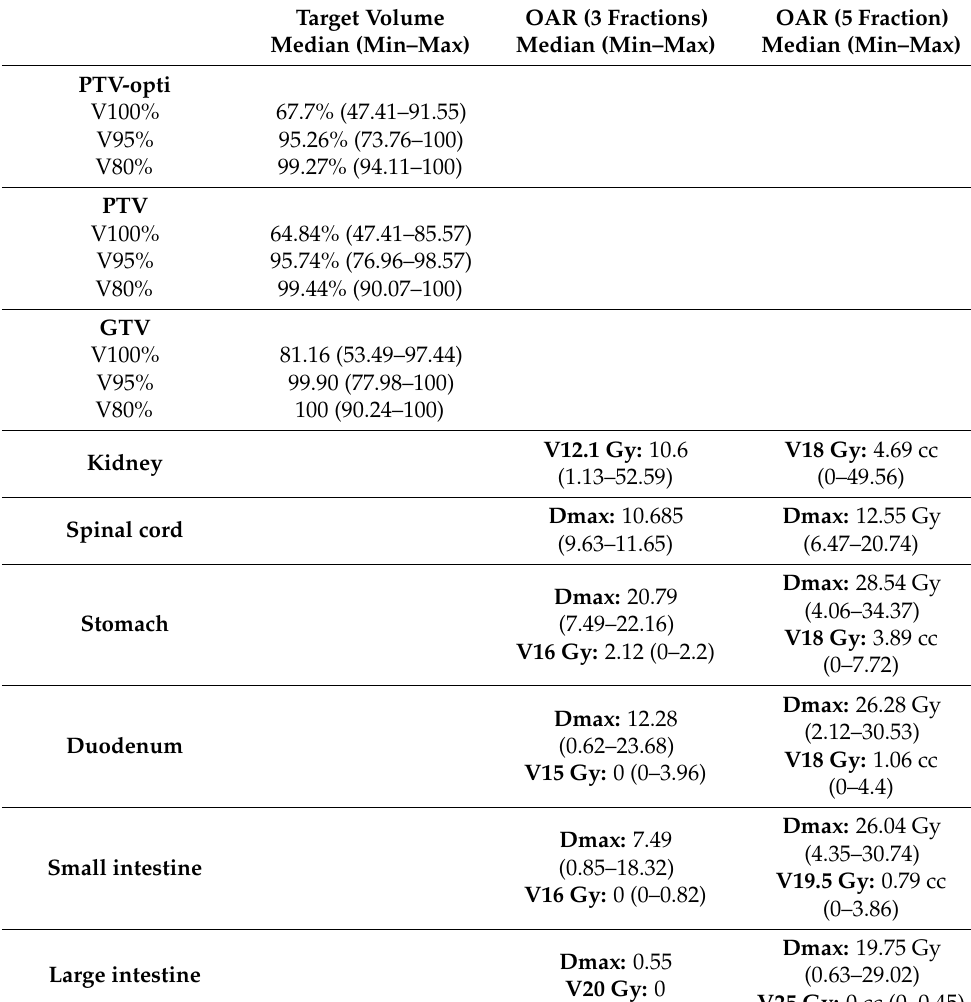
Table 3. Target volume and OAR’s dosimetric results for the initial